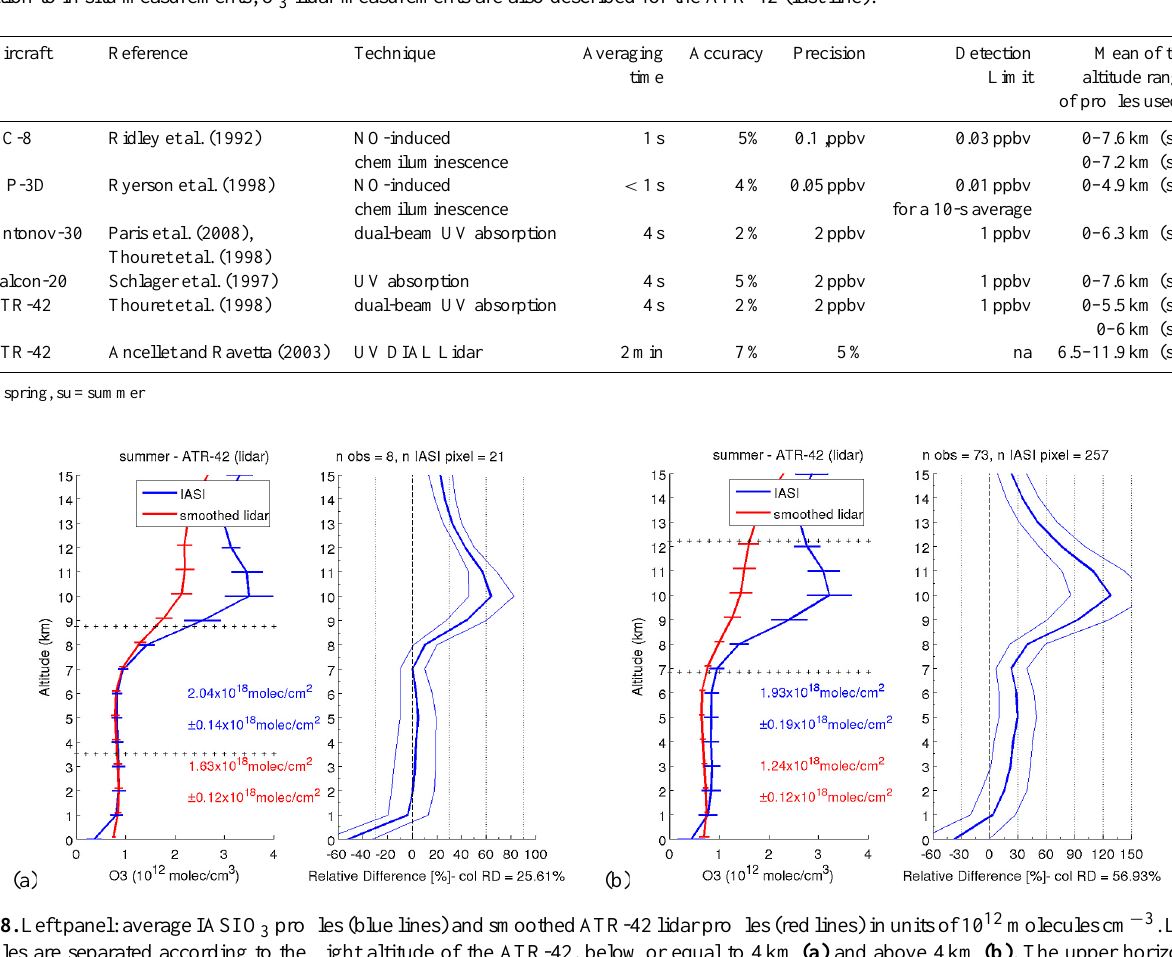
Table 1. Summary of O 3 in situ measurements on board the five aircraft used for this validation study and involved in POLARCAT. In addition to in situ measurements, O 3 lidar measurements are also described for the ATR-42 (last line).